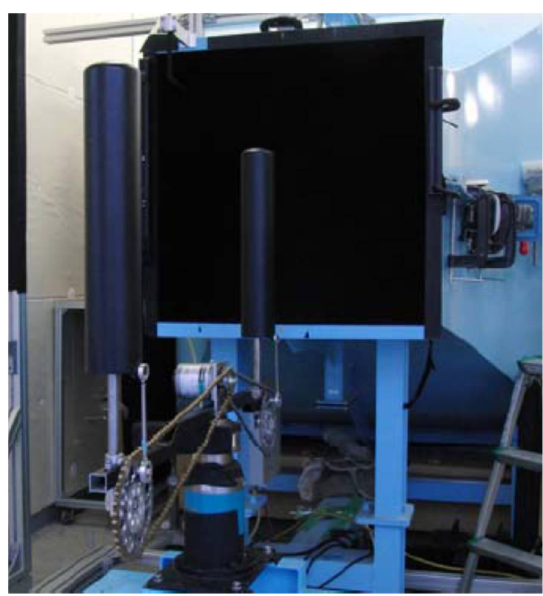
Figure 4. Two oscillating circular cylinders in a tandem arrangement.